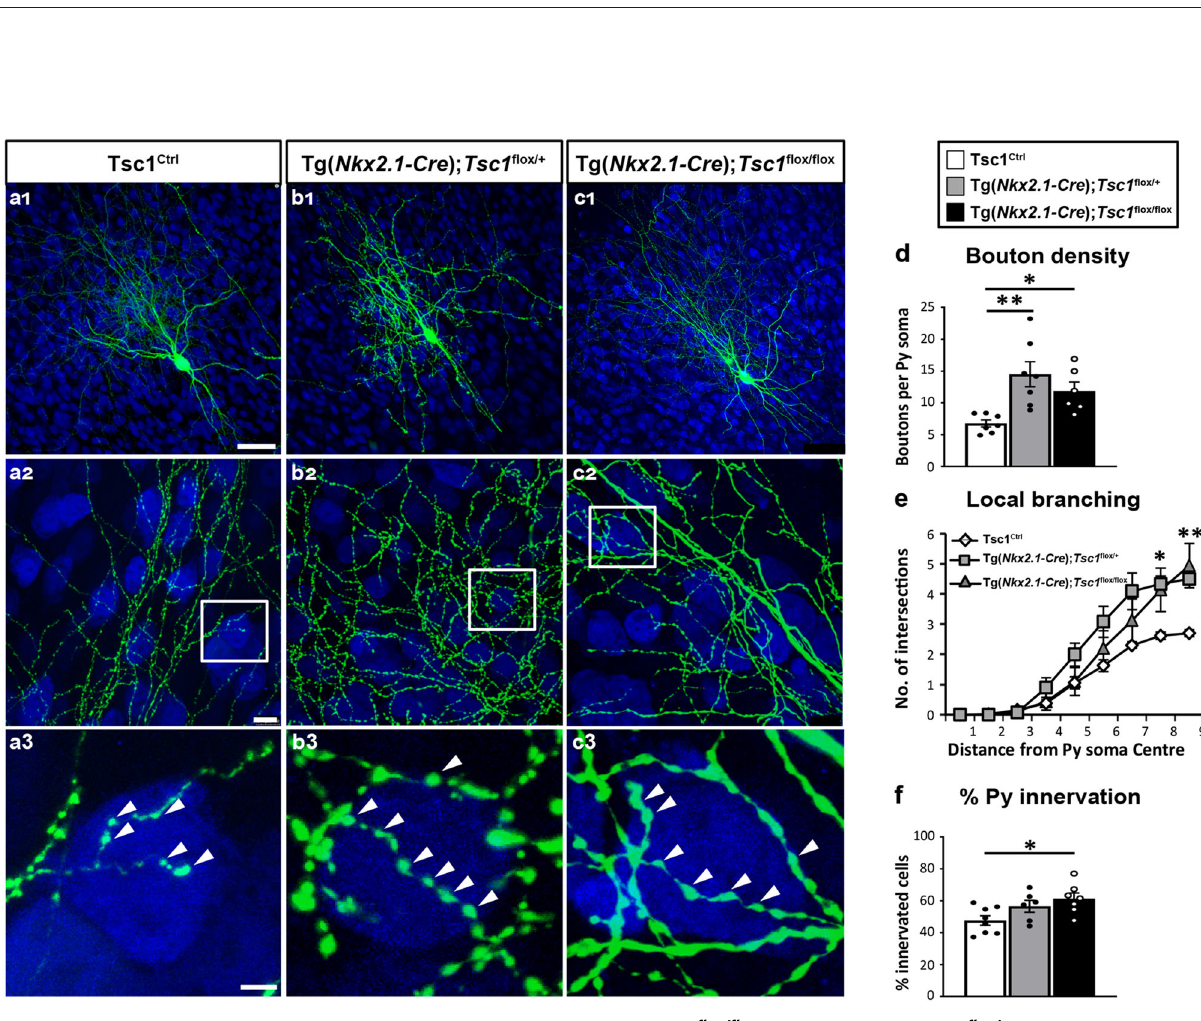
Fig. 4 PV cells show prematurely rich perisomatic innervation in Tg( Nkx2.1-Cre ); Tsc1 fl ox/ fl ox and Tg( Nkx2.1-Cre ); Tsc1 fl ox/ + mice at EP18. a1 A PV cell (green) amongst NeuN immunostained neurons (in blue) in cortical organotypic culture from a Tsc1 Ctrl mouse at EP18. a2 PV cell from Tsc1 Ctrl slice shows characteristic branching and multiple boutons (arrowheads) on the postsynaptic somata ( a3 ). PV cells from Tg( Nkx2.1-Cre ); Tsc1 fl ox/ + mice ( b1 – b3 ) and Tg ( Nkx2.1-Cre ); Tsc1 fl ox/ fl ox mice ( c1 – c3 ) show increased bouton density ( d ) (one-way ANOVA, ** p = 0.0039; Holm – Sidak ’ s multiple comparisons: Tsc1 Ctrl vs Tg ( Nkx2.1-Cre ); Tsc1 fl ox/ + ** p = 0.0023; Tsc1 Ctrl vs Tg( Nkx2.1-Cre ); Tsc1 fl ox/ fl ox * p = 0.0242). Number of mice: Tsc1 Ctrl n = 7, Tg( Nkx2.1-Cre ); Tsc1 fl ox/ + n = 7, Tg ( Nkx2.1-Cre ); Tsc1 fl ox/ fl ox n = 6. e Local branching (one-way ANOVA * p = 0.0113 (Radius 8), ** p = 0.0096 (Radius 9); Holm – Sidak ’ s multiple comparisons: (Radius 8) Tsc1 Ctrl vs Tg( Nkx2.1-Cre ); Tsc1 fl ox/ + * p = 0,0155; Tsc1 Ctrl vs Tg( Nkx2.1-Cre ); Tsc1 fl ox/ fl ox * p = 0.0425, Tg( Nkx2.1-Cre ); Tsc1 fl ox/ + vs Tg( Nkx2.1-Cre ); Tsc1 fl ox/ fl ox p = 0.8062; (Radius 9) Tsc1 Ctrl vs Tg( Nkx2.1-Cre ); Tsc1 fl ox/ + * p = 0.0317; Tsc1 Ctrl vs Tg( Nkx2.1-Cre ); Tsc1 fl ox/ fl ox * p = 0.0148, Tg( Nkx2.1-Cre ); Tsc1 fl ox/ + vs Tg( Nkx2.1-Cre ); Tsc1 fl ox/ fl ox p = 0.9738). Number of mice: Tsc1 Ctrl n = 7, Tg( Nkx2.1-Cre ); Tsc1 fl ox/ + n = 5, Tg( Nkx2.1-Cre ); Tsc1 fl ox/ fl ox n = 6. f Percentage of innervation (one-way ANOVA, * p = 0.0254; Holm – Sidak ’ s multiple comparisons: Tsc1 Ctrl vs Tg( Nkx2.1-Cre ); Tsc1 fl ox/ + p = 0,0823; Tsc1 Ctrl vs Tg( Nkx2.1-Cre ); Tsc1 fl ox/ fl ox * p = 0.0168). Number of PV cells: Tsc1 Ctrl n = 8, Tg( Nkx2.1-Cre ); Tsc1 fl ox/ + n = 6, Tg( Nkx2.1-Cre ); Tsc1 fl ox/ fl ox n = 7. Scale bars: a1 – c1 , 20 µ m; a2 – c2 , 10 µ m, a3 – c3 , 3 µ m. Data represent mean±SEM. Source data are provided as a Source Data fi le.